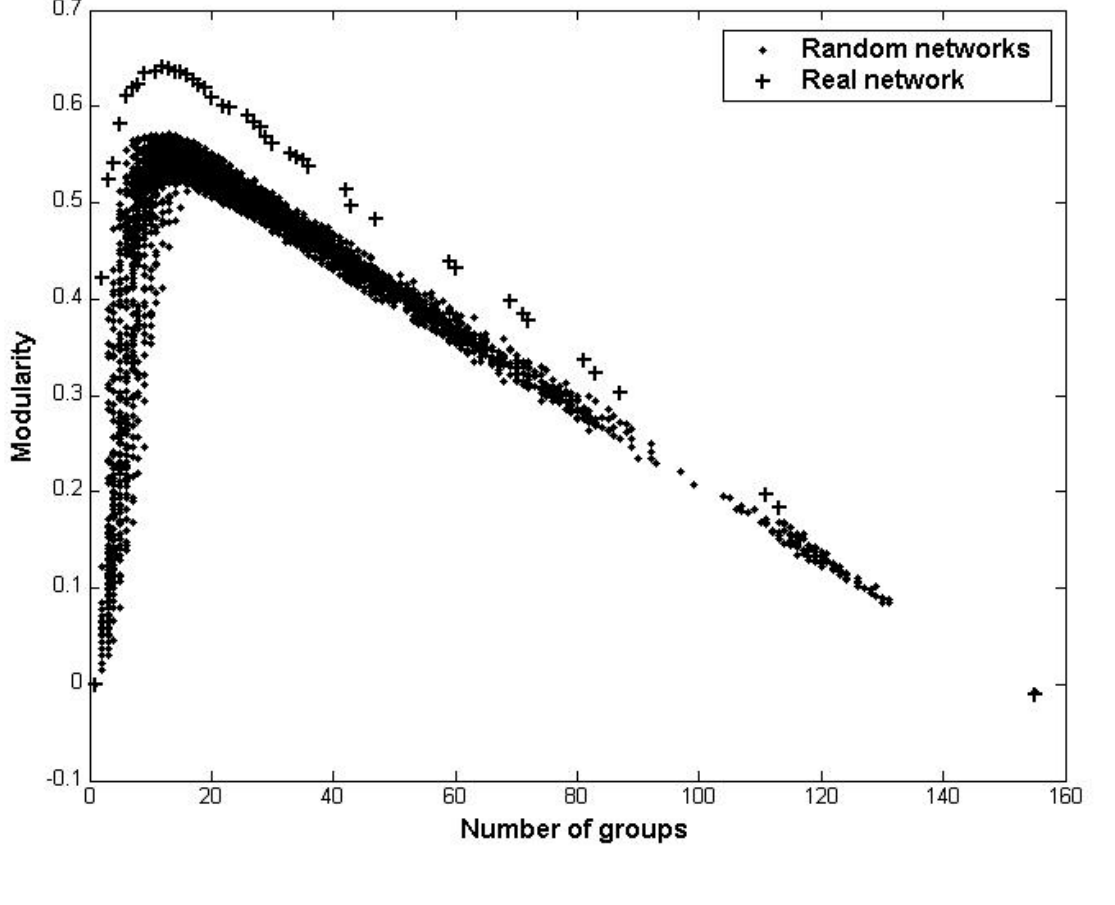
Fig. 5. Values of the Modularily plotted vs. the number of groups for all hierarchical levels using the Community structure method (Newman and Girvan 2004). Dots refer to the Modularity calculated from 100 randomly generated networks with the same number of nodes and links as the observed real-world social network. Crosses represent the calculated level of Modularity for the observed